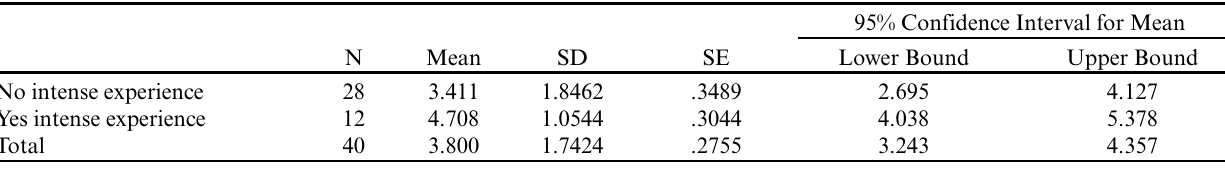
Table 2. ANOVA descriptives for impact of intense experience on level of